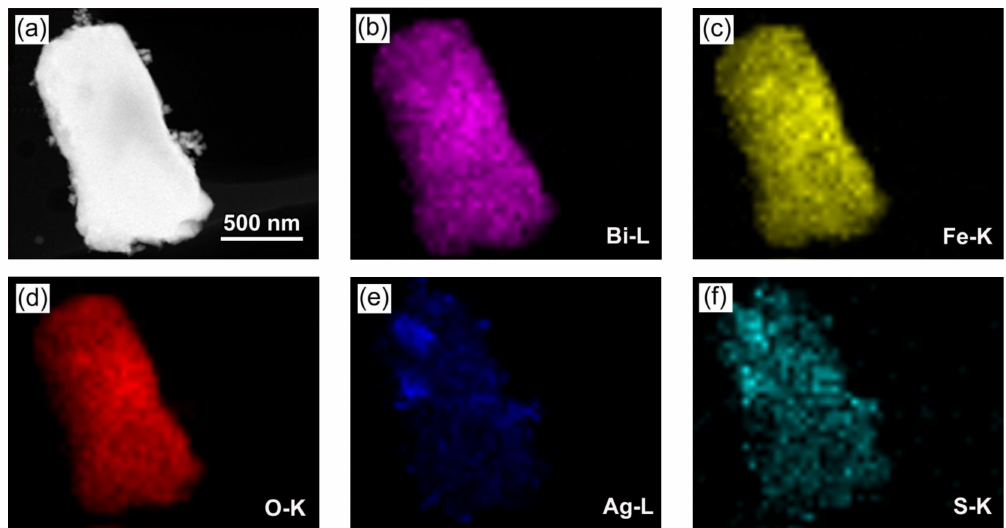
Figure 5. ( a ) Dark-field scanning TEM (DF-STEM) image of 15% Ag 2 S/BiFeO 3 . ( b – f ) The energy-dispersive X-ray elemental mapping images of the region shown in